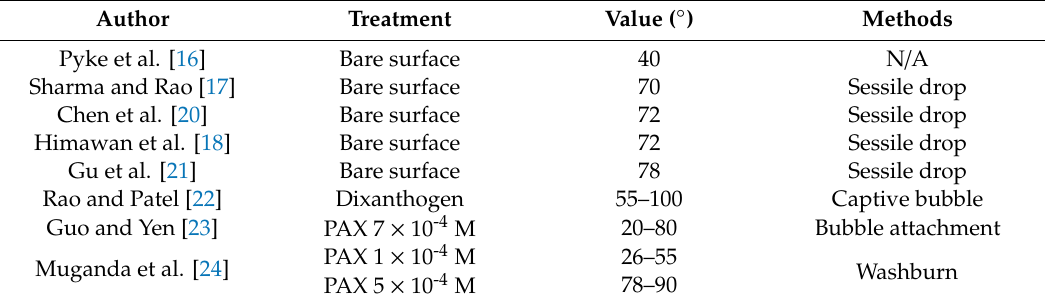
Table 3. Water contact angle on chalcopyrite surface reported by literature .